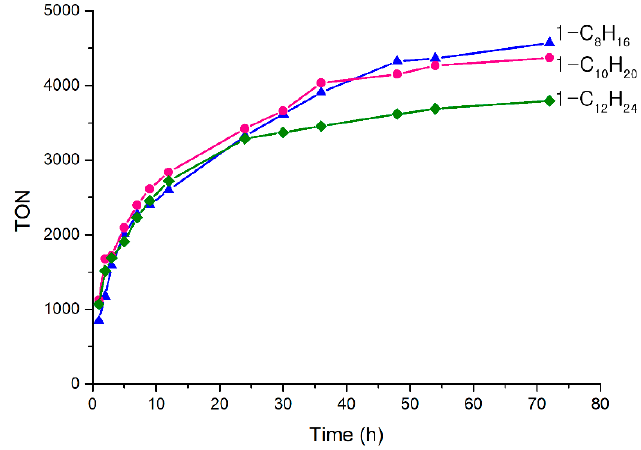
Figure 2. Conversion vs. time at various temperatures.